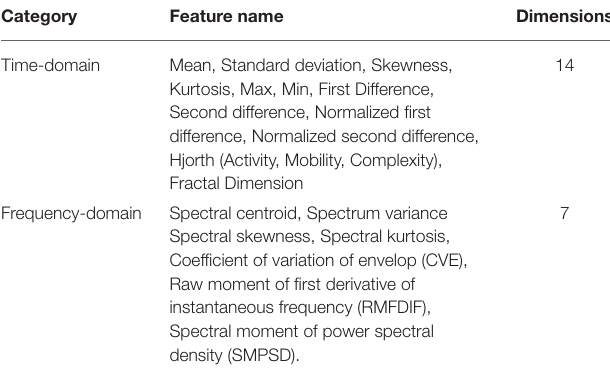
TABLE 1 | List of extracted features for each